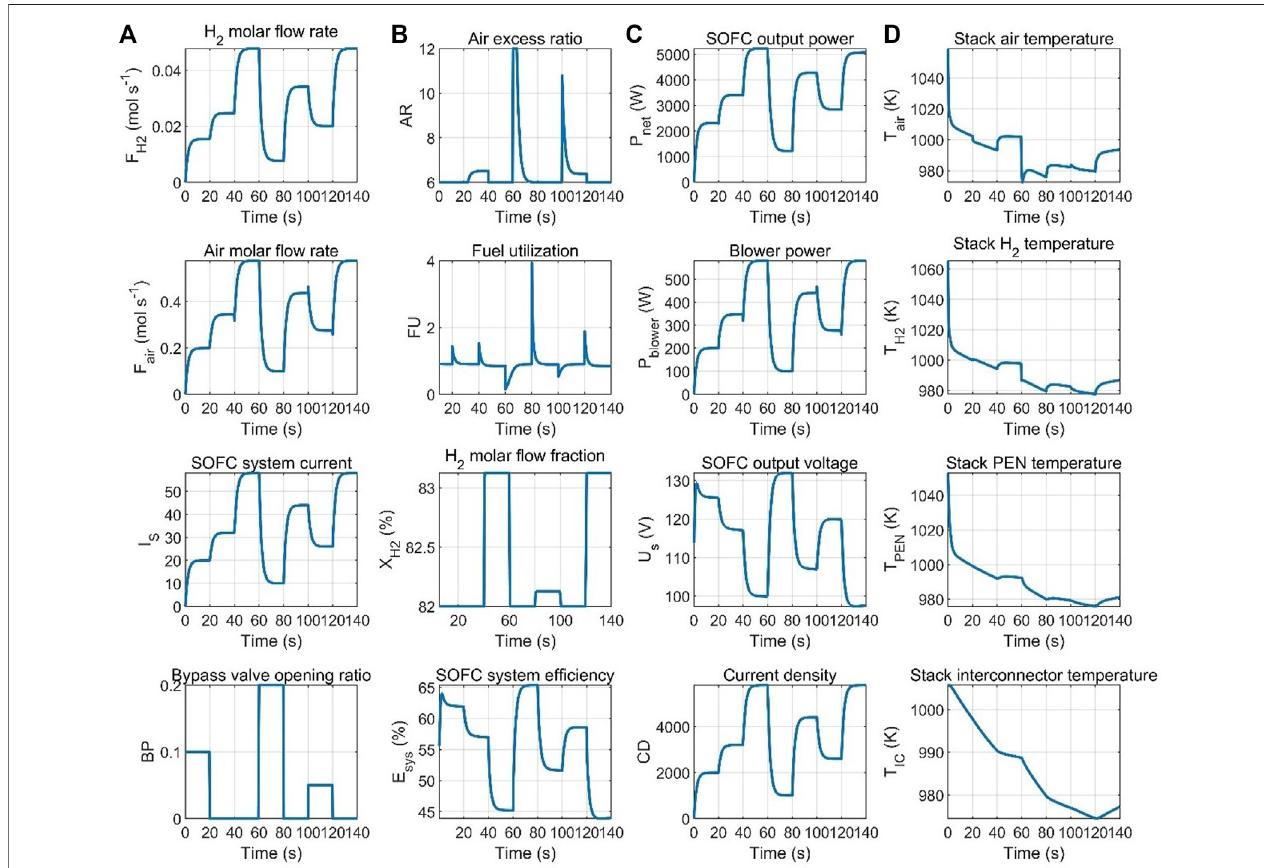
FIGURE 6 | Characteristics of the SOFC-based DC microgrid system. (A) Input characteristic and stack remain H 2 molar fl ow fraction; (B) related outputs considering ef fi ciency and fuel exhaustion; (C) output electrical characteristic; and (D) Output thermal characteristic.